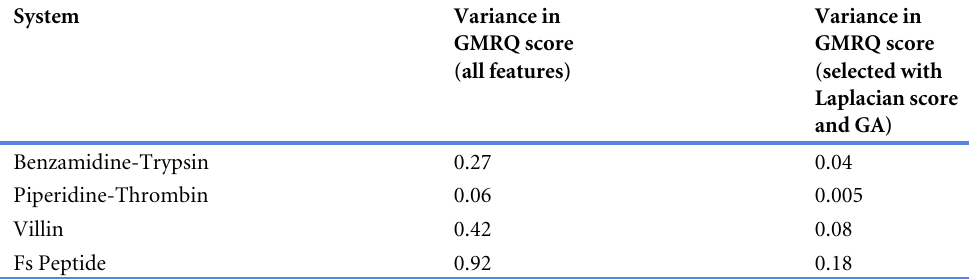
Table 3 Compares the variance in the GMRQ score when all features are used and features selected using Laplacian with GA is used. This shows that using selected features helps to avoid